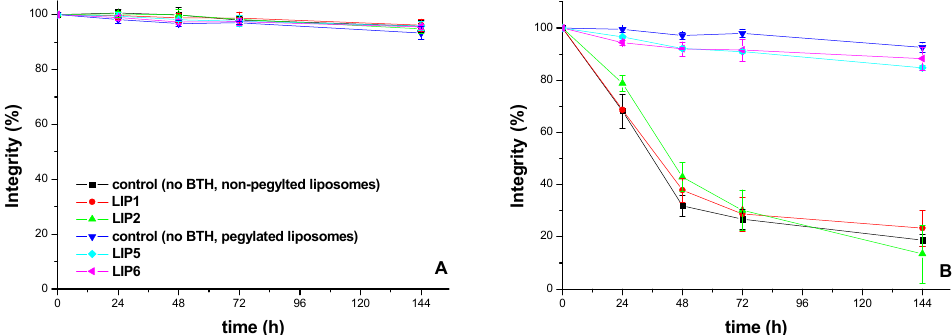
Figure 6. Integrity of non-pegylated BTH-nanoliposomes (LIP1 and LIP2) and pegylated BTH-nanoliposomes (LIP5 and LIP6) and their corresponding control nanoliposomes (with no BTH on their surface), during incubation in buffer ( A ) or FCS (80% v / v ) ( B ) at 37 °C. Each data point is the mean of at least 3 different experiments and the bar is the SD of the mean.